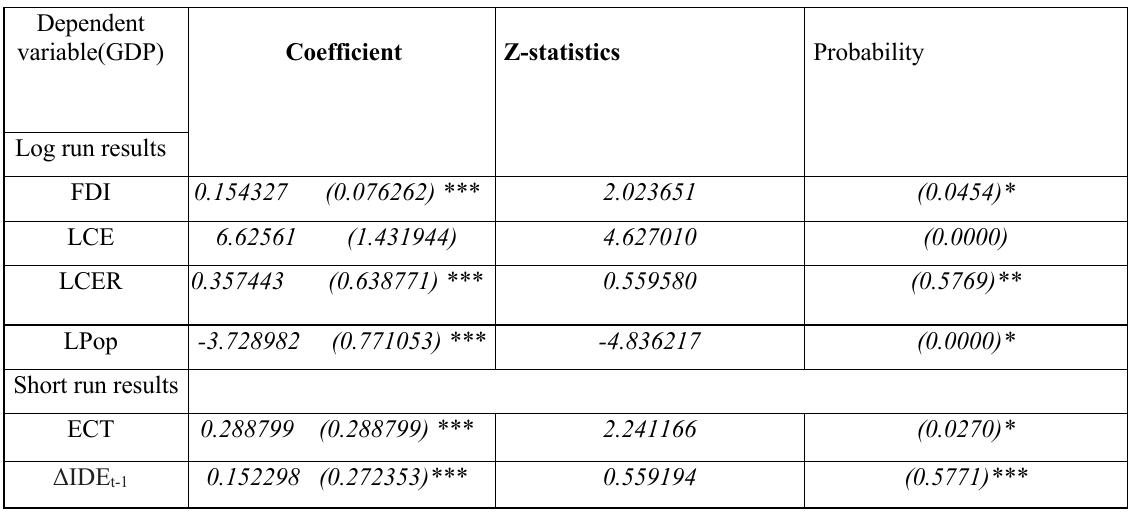
Table 6. Results from Models